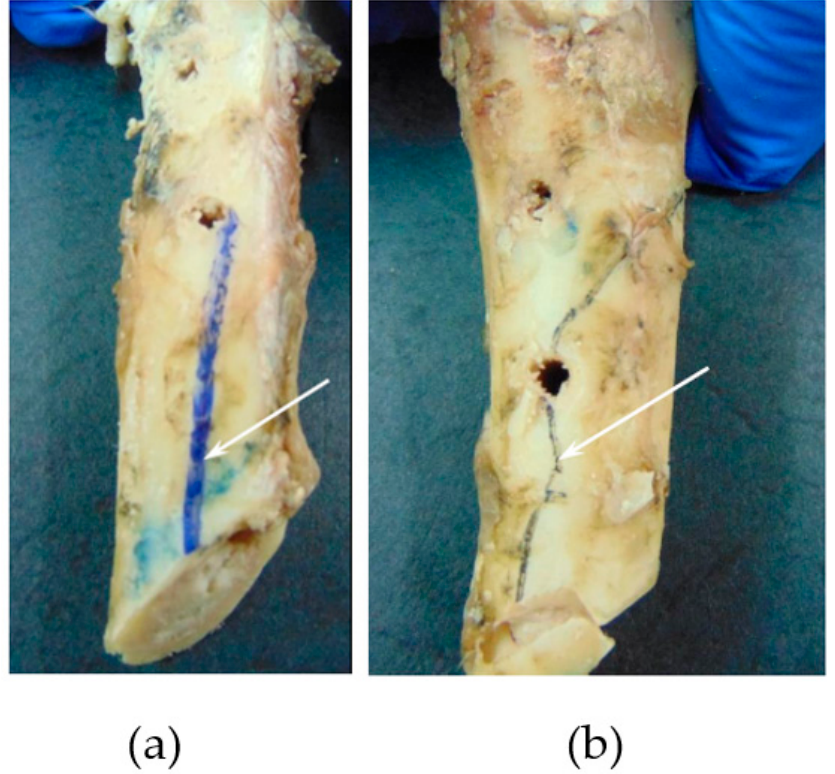
Figure 12. Fracture propagation, including ( a ) proximal epiphysis and ( b ) distal epiphysis.